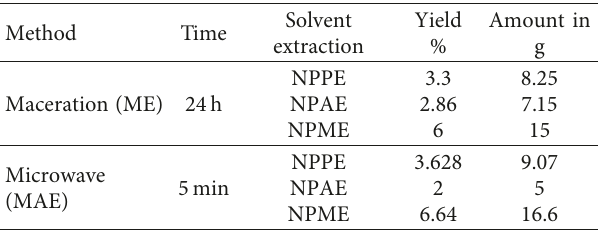
Table 1: Comparison of yields of maceration and microwave extraction with different solvents from N. pulmonarioides.